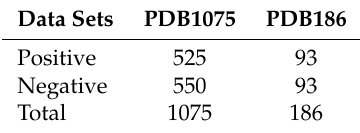
Table 1. The detail information of two benchmark data